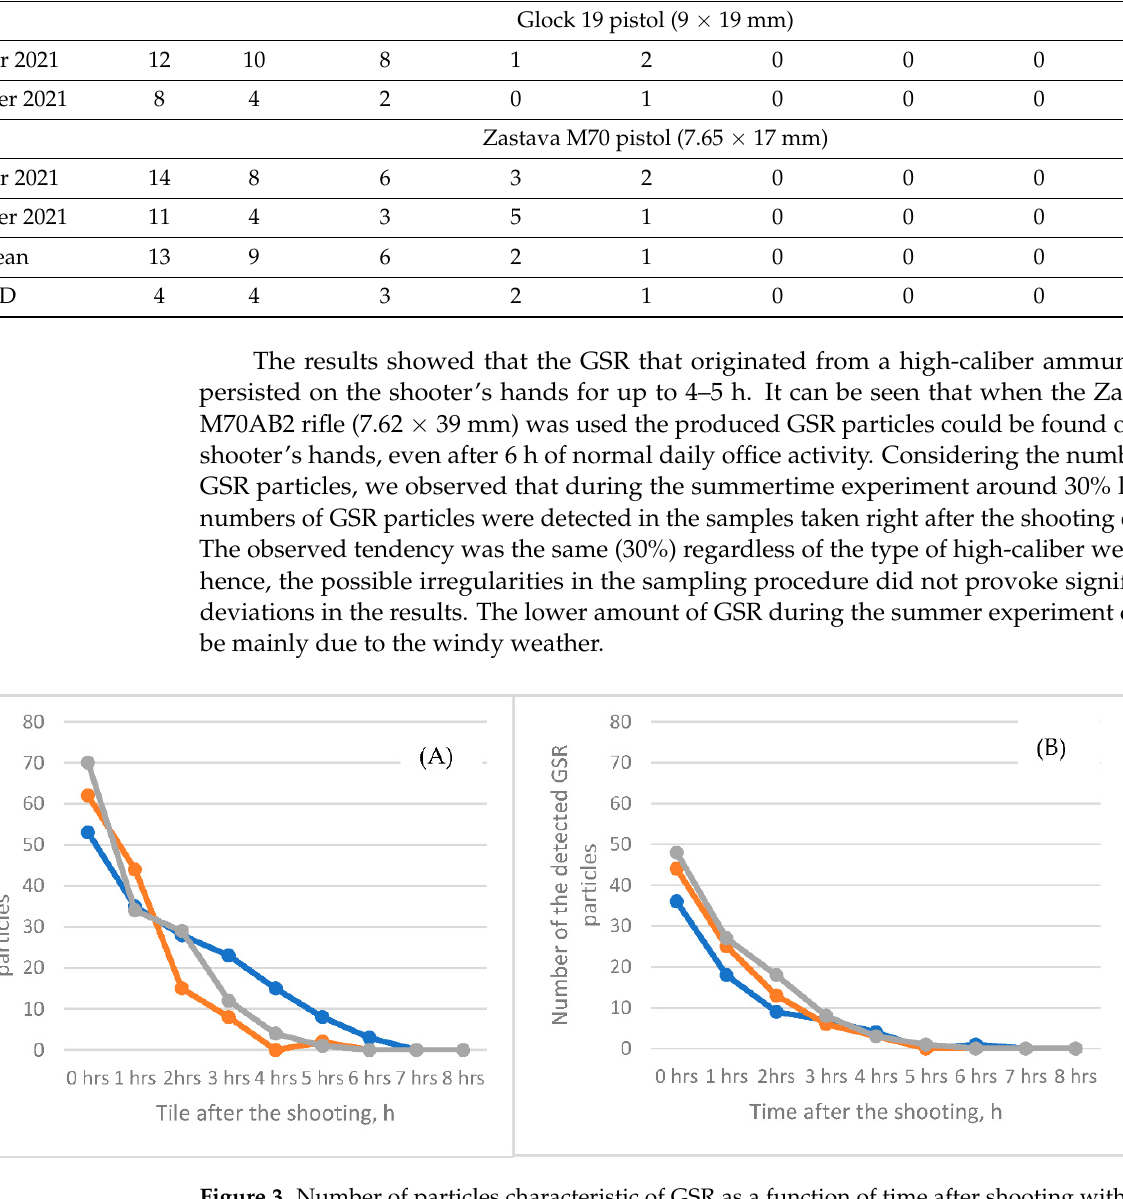
Table 6. Number of particles characteristic of GSR as a function of time after shooting with a low ‐ caliber ammunition. Each person made one shot.